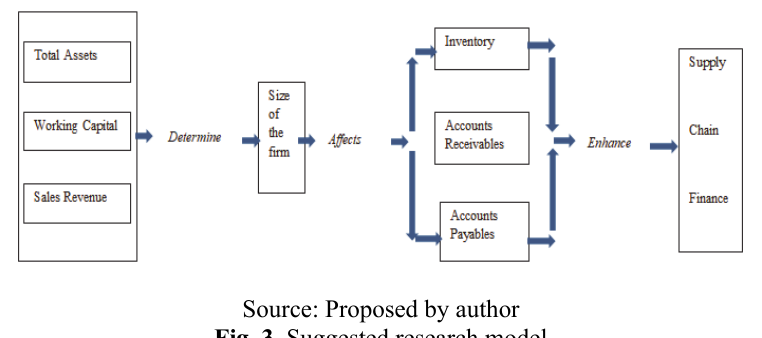
Fig. 3. Suggested research model